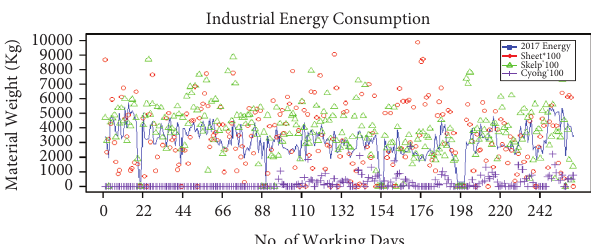
Figure 9: Different type’s material weight of manufactured products with usages of energy for the number of working days in 2017.